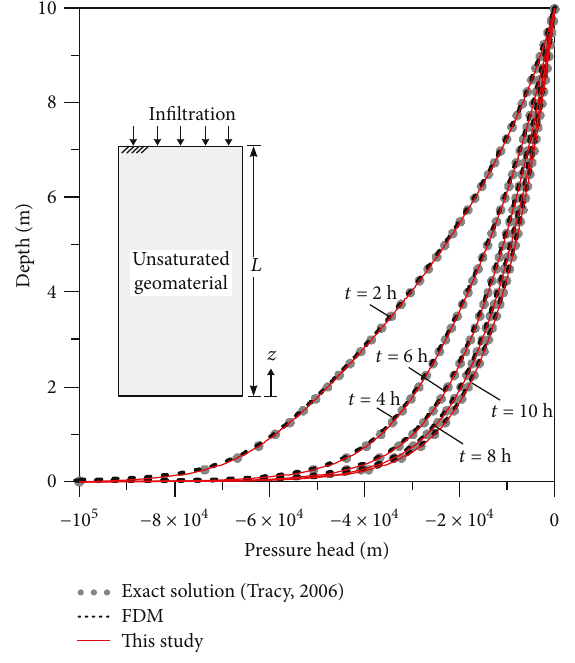
Figure 3: Comparison of results for solving one-dimensional Green-Ampt problem.